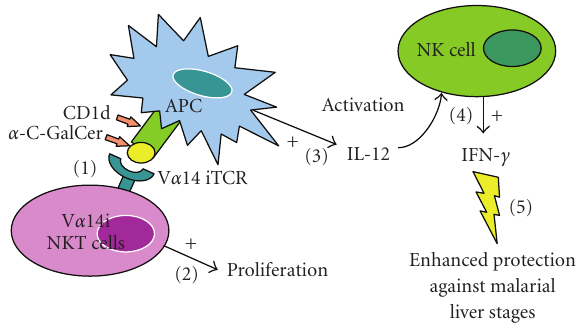
Figure 7: Mechanism of α -C-GalCer’s enhanced therapeutic e ff ect against malarial liver stages: (1) α -C-GalCer presented by CD1d molecules expressed on APCs stimulates, (2) enhanced (+) prolif- eration by V α 14i NKT cells relative to α -GalCer, and (3) enhanced (+) activation and IL-12 release by APCs compared to α -GalCer, which (4) induces augmented IFN- γ production by NK cells. This increased IFN- γ is responsible for (5) the better protection against malarial liver stages exhibited by α